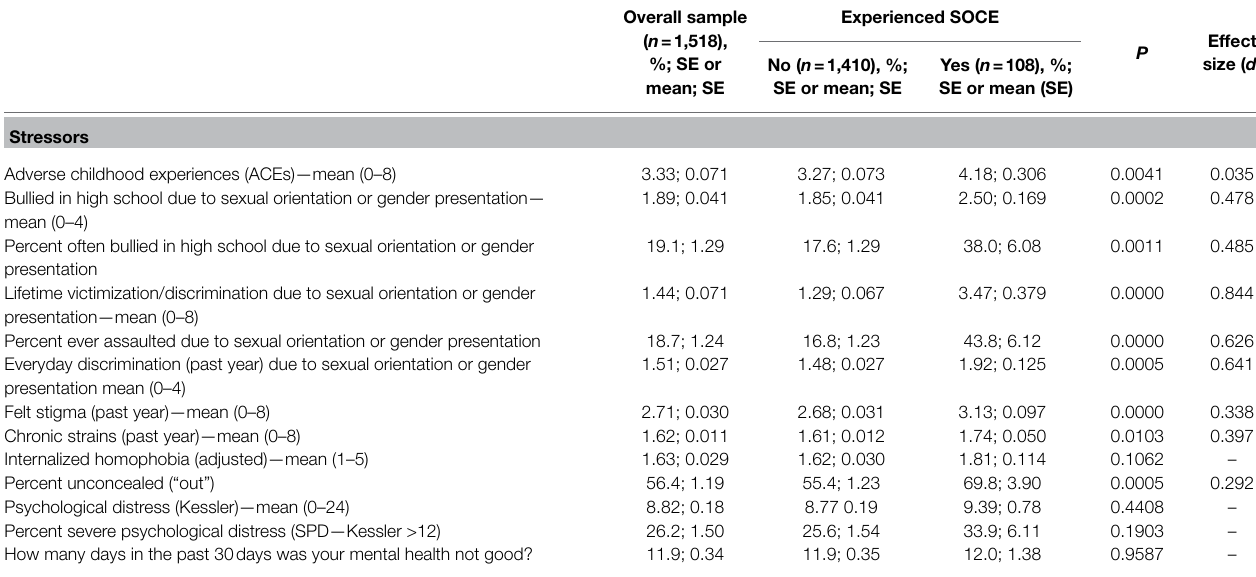
TABLE 2 | Minority stressors and mental health by experiencing SOCE, counts, and weighted proportions: probability sample of sexual minorities, United States, 2016–2018 ( N = 1,518).